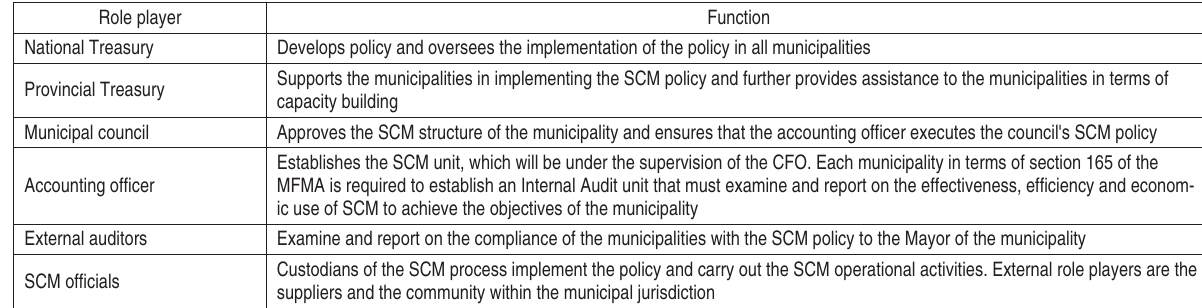
Table 1. Key role players and functions in municipal SCM